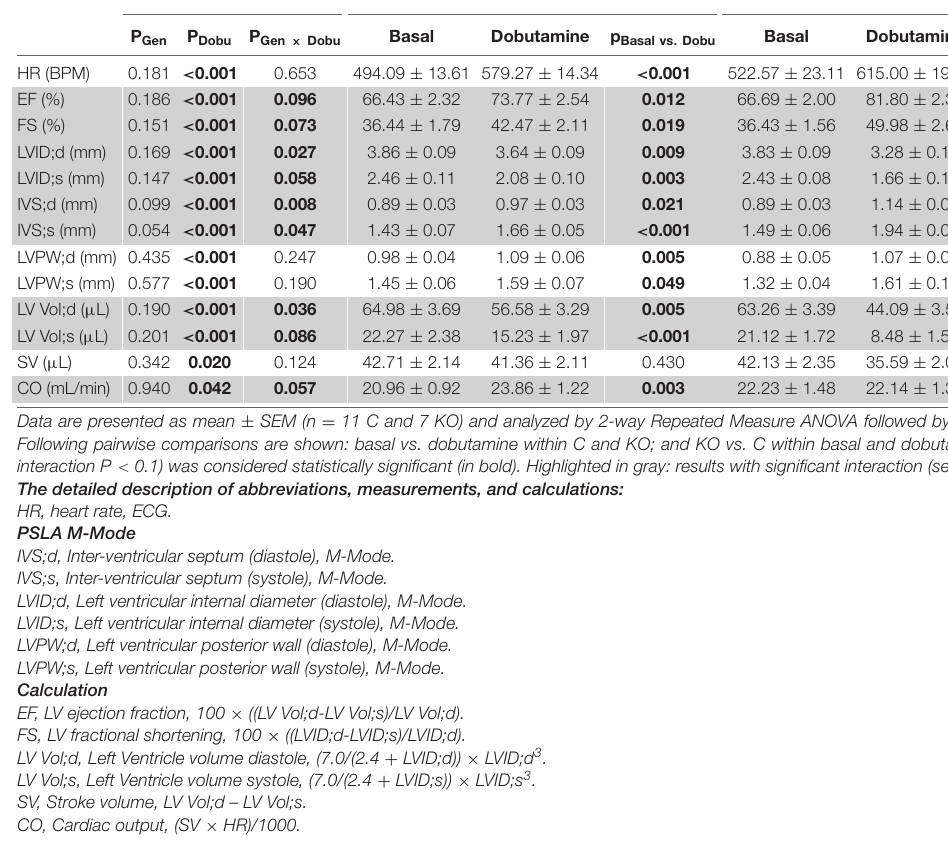
TABLE 1 | Cardiac response to dobutamine assessed by echocardiography 10 weeks after induction of KO by tamoxifen. 2-way RM Anova Control KO Basal Dobutamine P Gen P Dobu P Gen × Dobu Basal Dobutamine p Basal vs . Dobu Basal Dobutamine p Basal vs . Dobu p KO vs . C p KO vs .